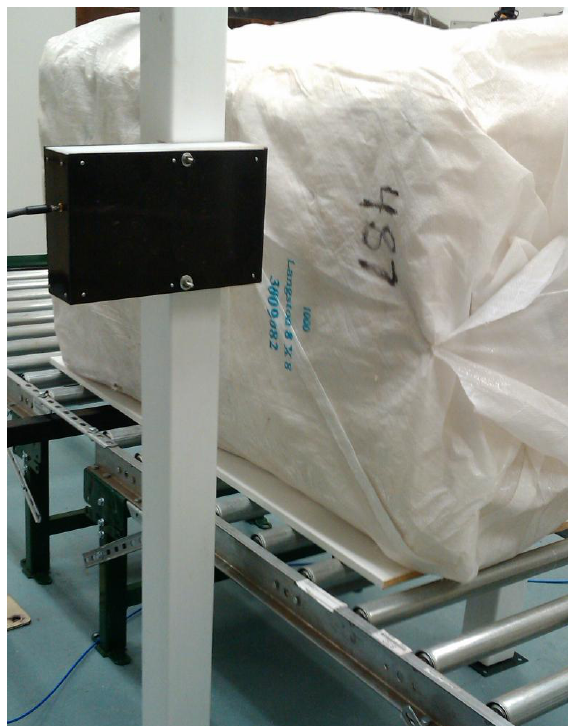
Figure 2. Experimental apparatus to convey the cotton bales past the imaging antennas to allow measurement of the signal response at specific targeted discrete positions along a